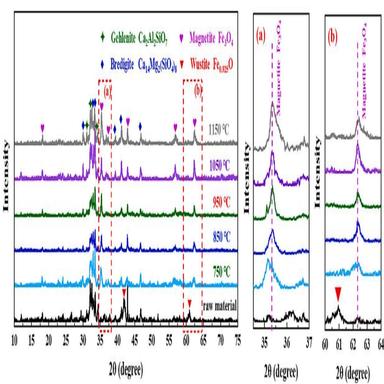
XRD patterns of steel slag raw materials treated at different temperatures.